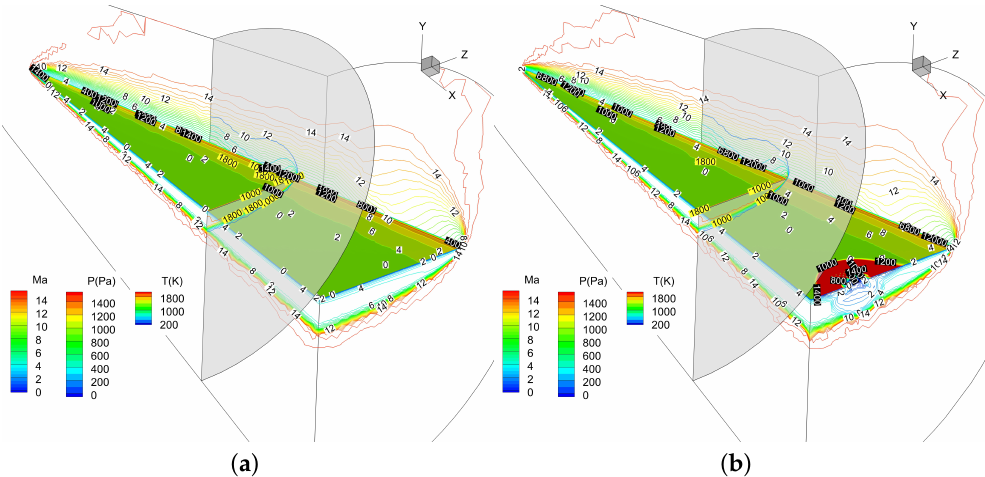
Figure 8. Flow Field Mach Number (Symmetry Plane, White Background Label), Temperature (Sec- tion Plane x = 0.612, Yellow Background Label Background) and HFV Surface Pressure (Black Back- ground Label) Contour Lines. ( a ) Baseline Case ( C M = 0.013891). ( b ) AJM Case 4 ( C M = − 0.006832). Table 6. Force and Moment Coefficients on Control